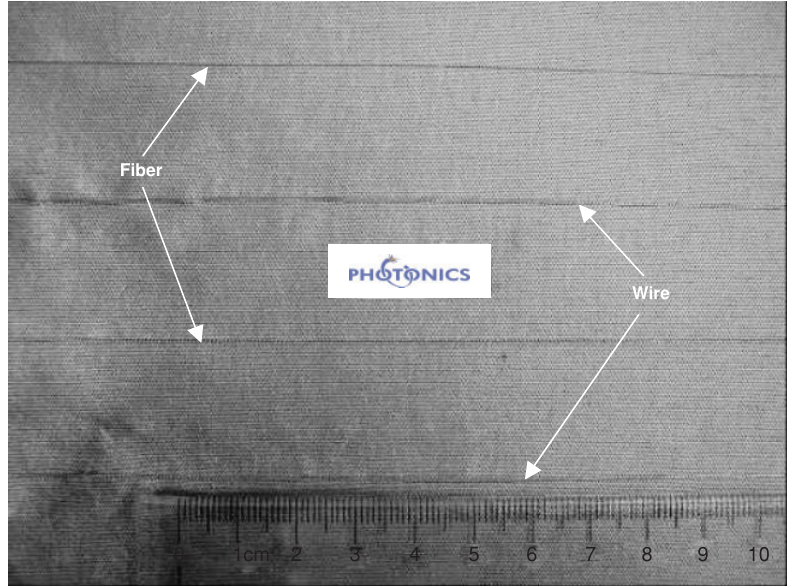
Figure 9 Different types of optical fibers and electronic wires integrated into plain woven